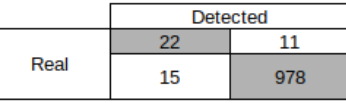
Figure 4. Confusion